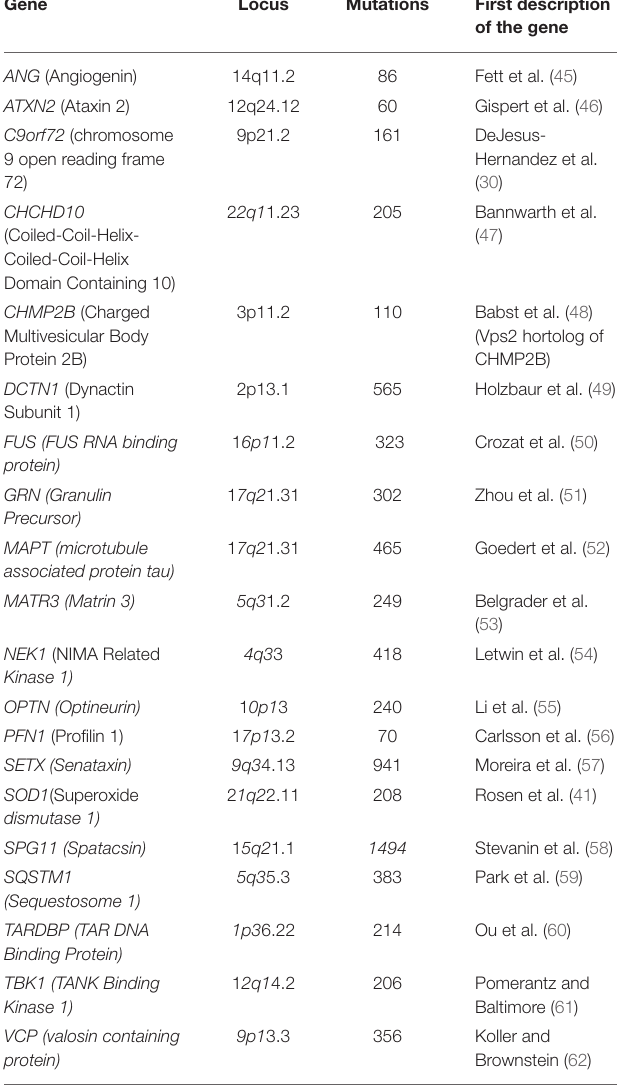
TABLE 1 | List of genes involved in ALS and FTD pathologies.